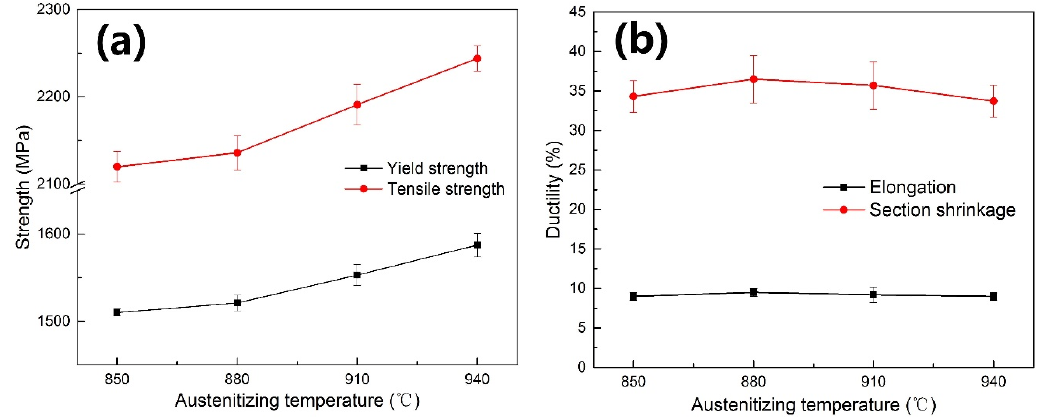
Figure 8. Tensile properties of MCLA martensite steel at different austenitizing temperatures: ( a ) yield strength and tensile strength; ( b ) elongation and section shrinkage.